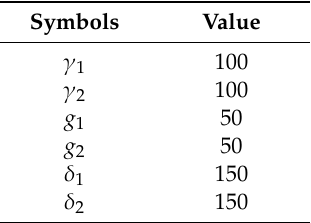
Table 2. Sliding mode adaptive observer